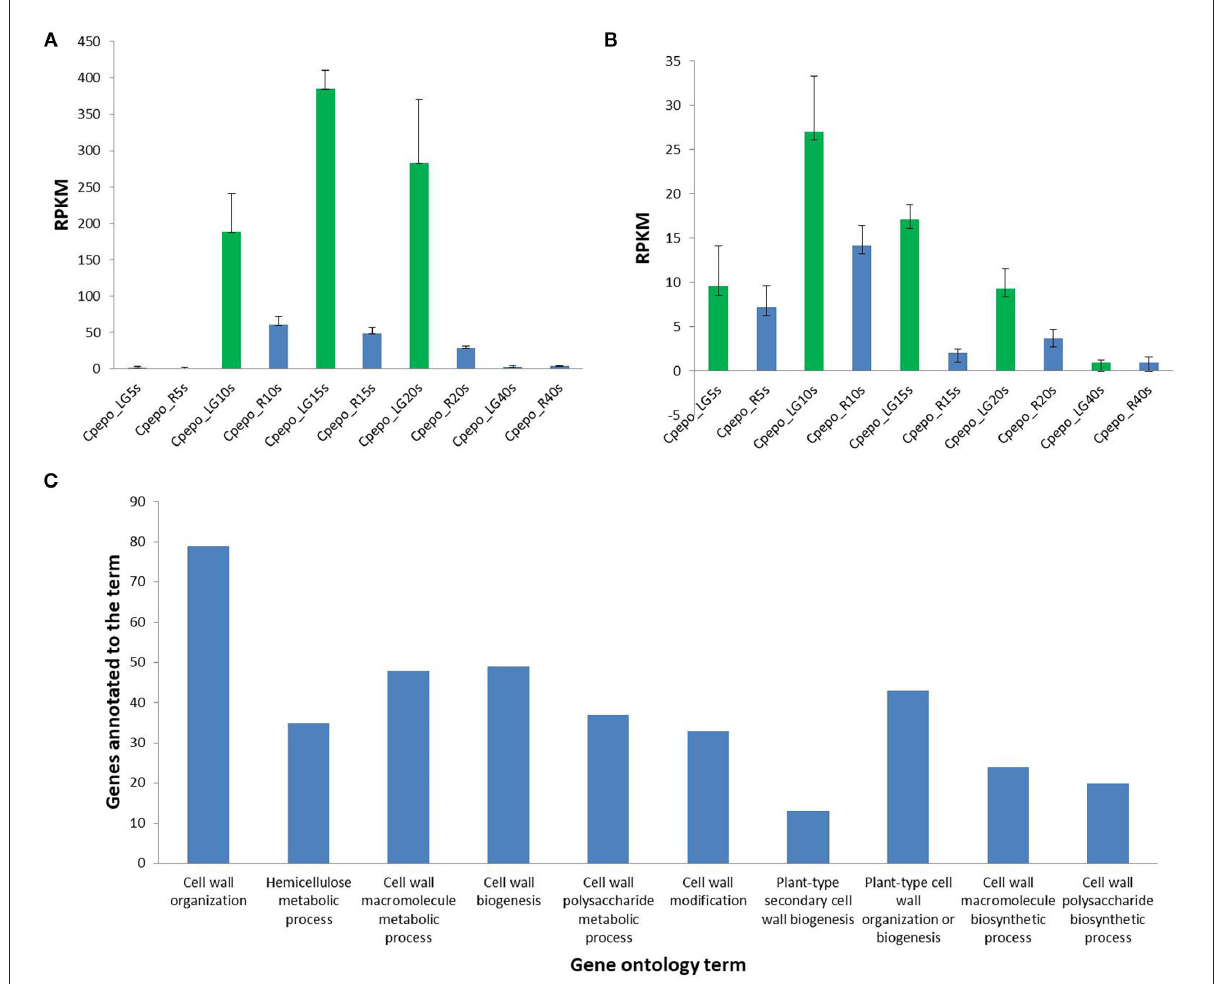
FIGURE6 Differential expression of genes, NAC ( Cp4.1 LG12g04350 ) (A) and MYB, ( Cp4.1LG12g03120 ) (B) in seeds of hull-less and hulled C. pepo ; where, RPKM, Reads per Kilobase of transcript per million mapped read; LG, hull-less seeded variety “Lady Godiva”; R, Hulled variety “Sweet Reeba”; 5, 10, 15, 20, and 40s corresponds to 5, 10, 15, 20, and 40 DAP (C) : Gene ontology analysis (Biological processes) from transcriptional differences between hull-less and hulled seeds at 15 and 20